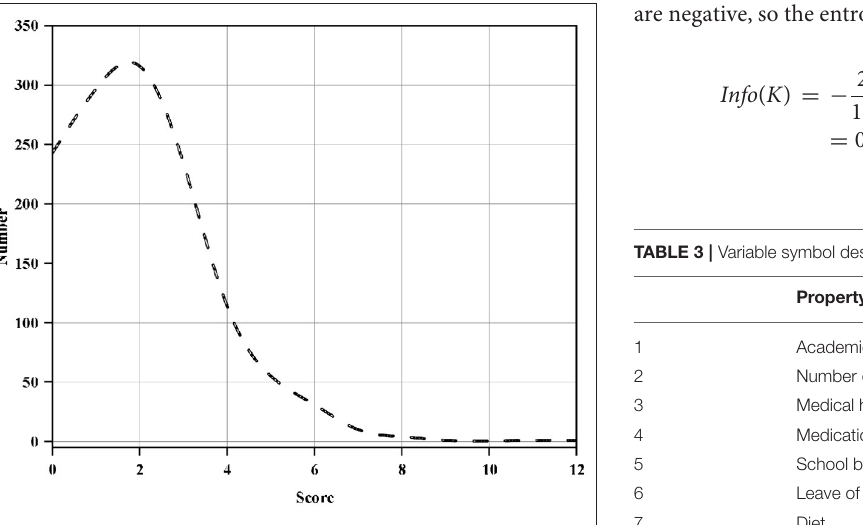
FIGURE 2 | Student psychological score pie chart.